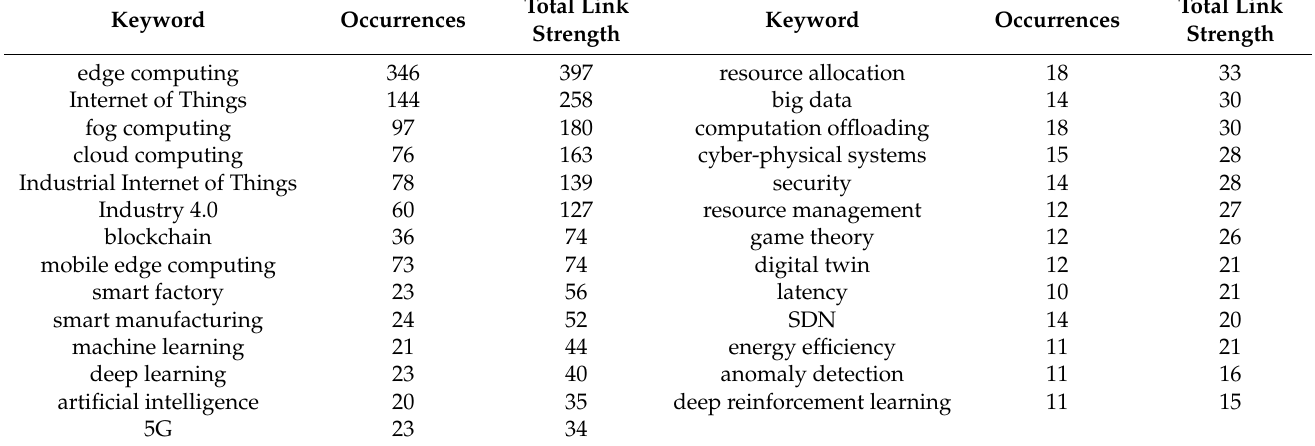
Table 4. The final list of